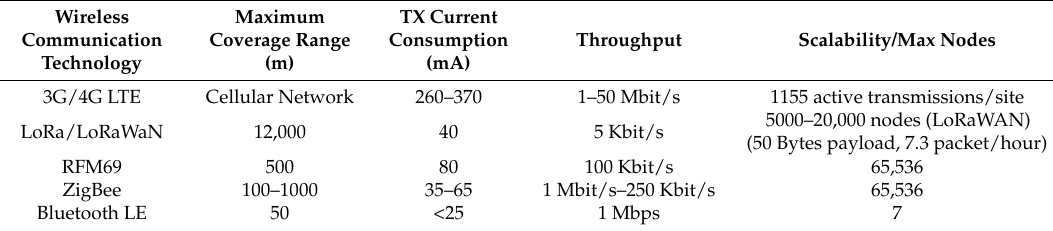
Table 1. Main characteristics of wireless communication technologies Measurements